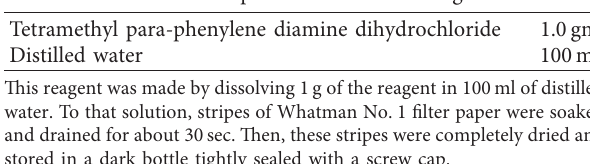
Table 12: Preparation of oxidase reagent.